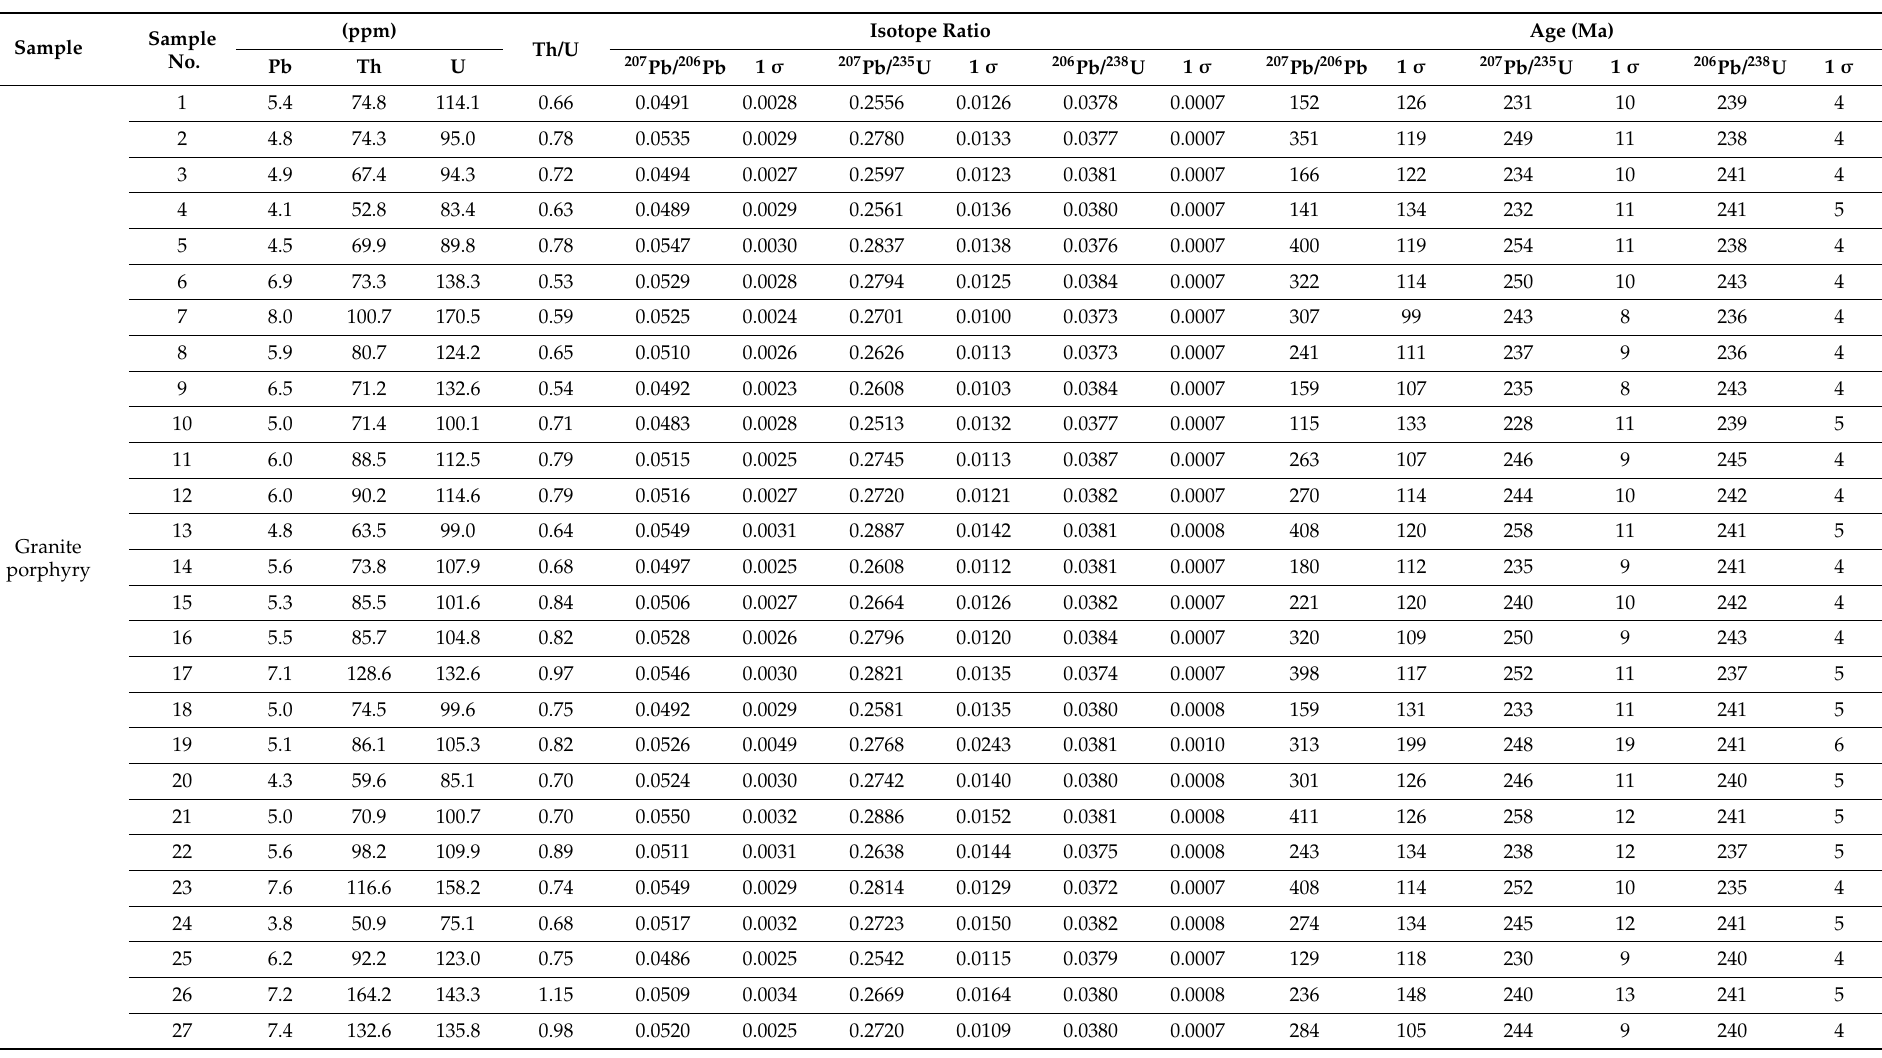
Table 1. LA-ICP-MS zircon U-Pb dating results of Asiha complex.